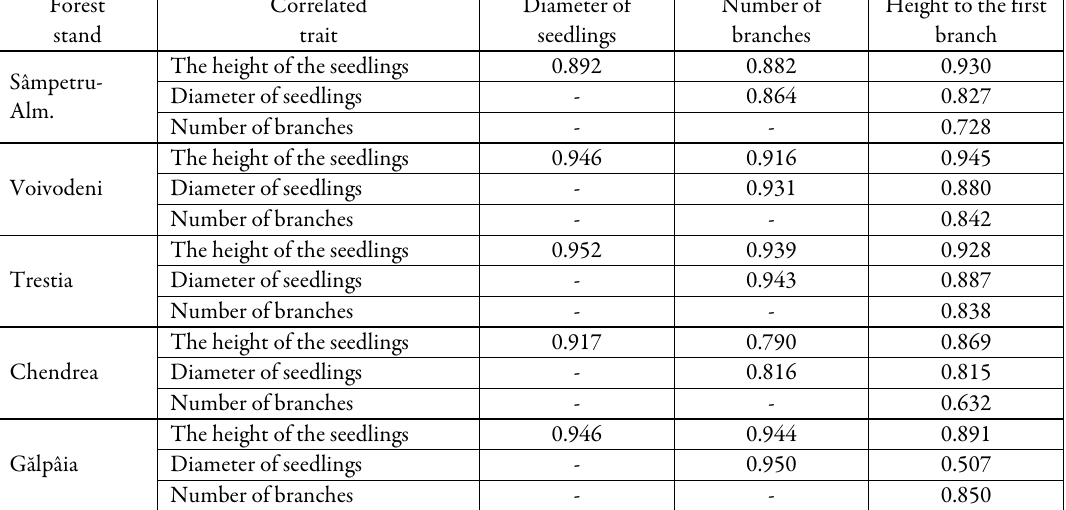
Table Table Table Table 7.7.7.7. Genotypic correlations between the analysed characteristics of the seedlings belonging to the selected R. pseudoacacia trees open pollinated, from five stands (there were analysed 100 randomised seedlings belongings to the half sib families, respectively plus trees selected from each stand)